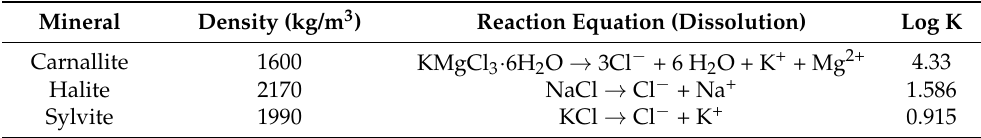
Figure 6. Heterogeneous rock distributions examined: The homogeneous potash salt (red) shown in Figure 5 is veined by layers with ( a ) 0 ◦ , ( b ) +10 ◦ , ( c ) − 10 ◦ inclination or inclusions of pure halite with correlation lengths of ( d ) 2:1, ( e ) 17:0.5 and ( f ) 34:1 that make up 13% to 15% of the potash seam. Table 1. Potash salt mineral densities and dissolution properties (modified from Steding et al.